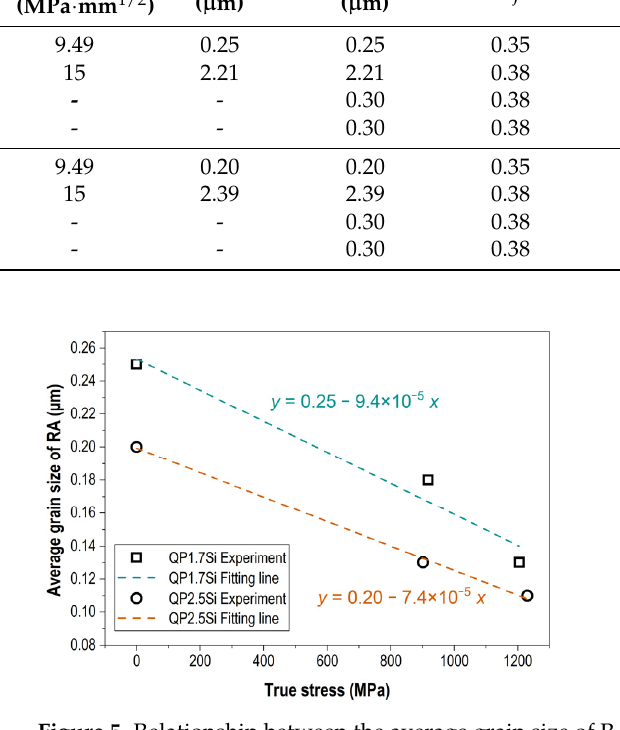
Figure 5. Relationship between the average grain size of RA with the true stress.